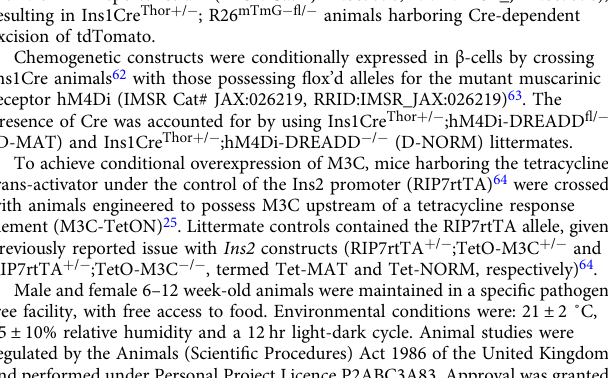
Fig. 9 Maintaining PDX1 LOW :PDX1 HIGH β -cell balance protects against islet failure. a – c A signi fi cant decrease in the proportion of PDX1 HIGH β -cells is detected in palmitate-treated islets ( a ), and this can be reversed using Ad-M3C ( b ), as shown by representative images ( c ) ( n = 7 islets/4 animals; two- way ANOVA, Bonferroni ’ s multiple comparison) (Palm: F = 4.28, DF = 20) (Palm + Ad-M3C: F = 0.90, DF = 20) (BSA, bovine serum albumin; Palm, 0.5 mM palmitate for 48 h) (scale bar = 42.5 µ m). Note that the same BSA-only (control) PDX1 fl uorescence intensity distribution is shown in both graphs ( a ) and ( b ) to allow cross-comparison (the experiments were performed in parallel). d – f Ca 2 + responses to glucose ( d ) and KCl ( e ) are blunted in palmitate-treated, but not palmitate + Ad-M3C-treated islets (n = 27 islets/4 animals; one-way ANOVA, Sidak ’ s multiple comparison) (G11: F = 18.80, DF = 2) (KCl: F = 23.13, DF = 2), as shown by mean traces ( f ). g Schematic showing that a decrease in the proportion of PDX1 LOW /MAFA LOW β -cells leads to altered islet Ca 2 + fl uxes, decreased expression of Ca 2 + -dependent genes such as Ascl1 , and broader changes to β -cell function, including impaired ATP/ADP and insulin responses to glucose. Bar graphs and traces show the mean ± SEM. Box-and-whiskers plot shows median and min-max. All tests are two-sided where